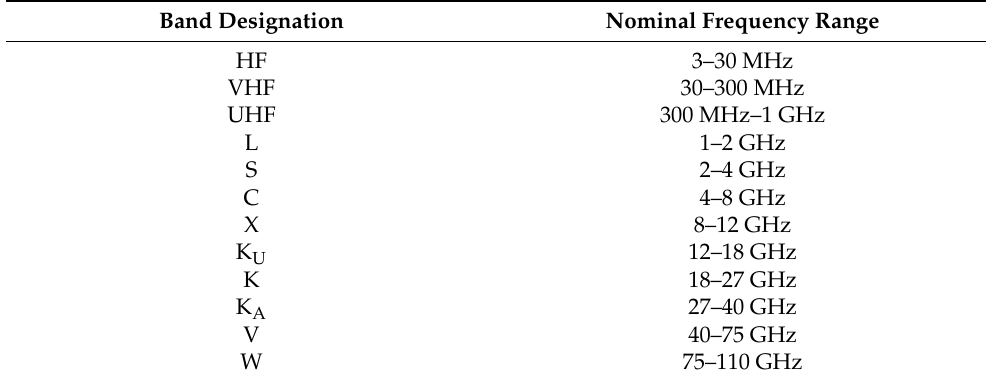
Table 3. IEEE band Designation and Nominal Frequency Range